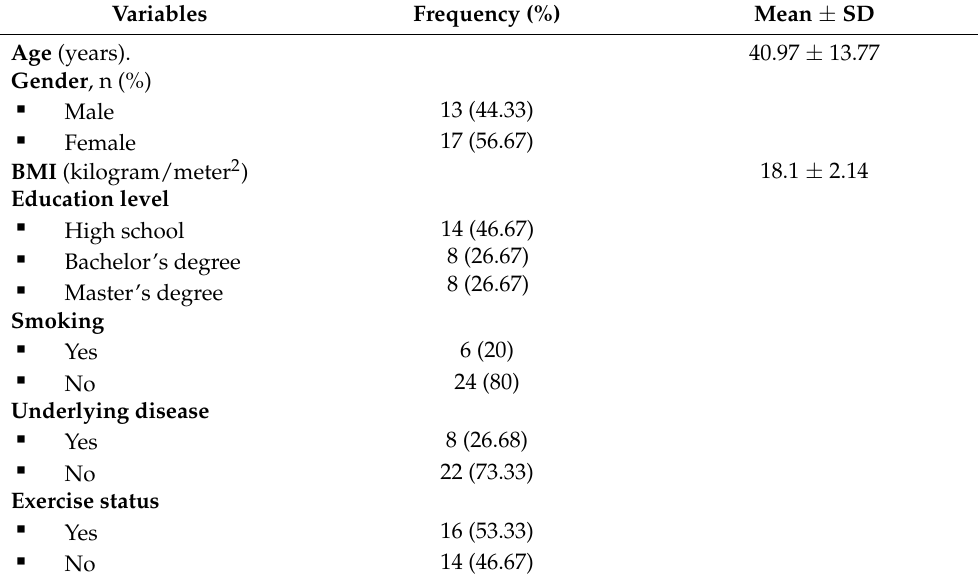
Table 1. General characteristics of 30 healthy participants.